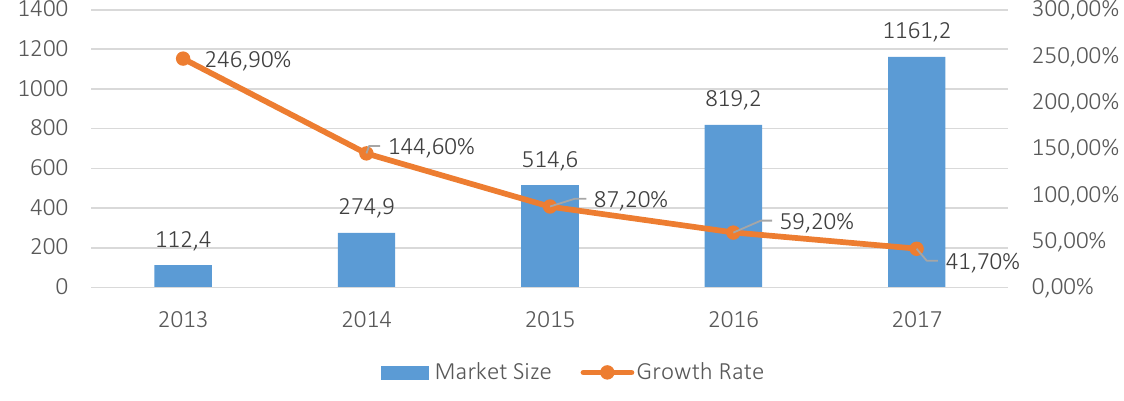
Figure 2. Market size of the Chinese mobile game industry (unit: hundred million